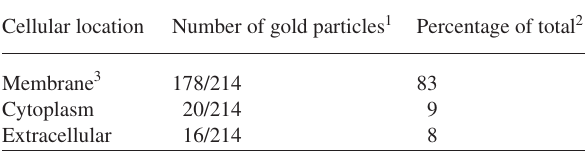
Table 1. Distribution of gold particles in thin sections of A. fulgidus . Cellular location